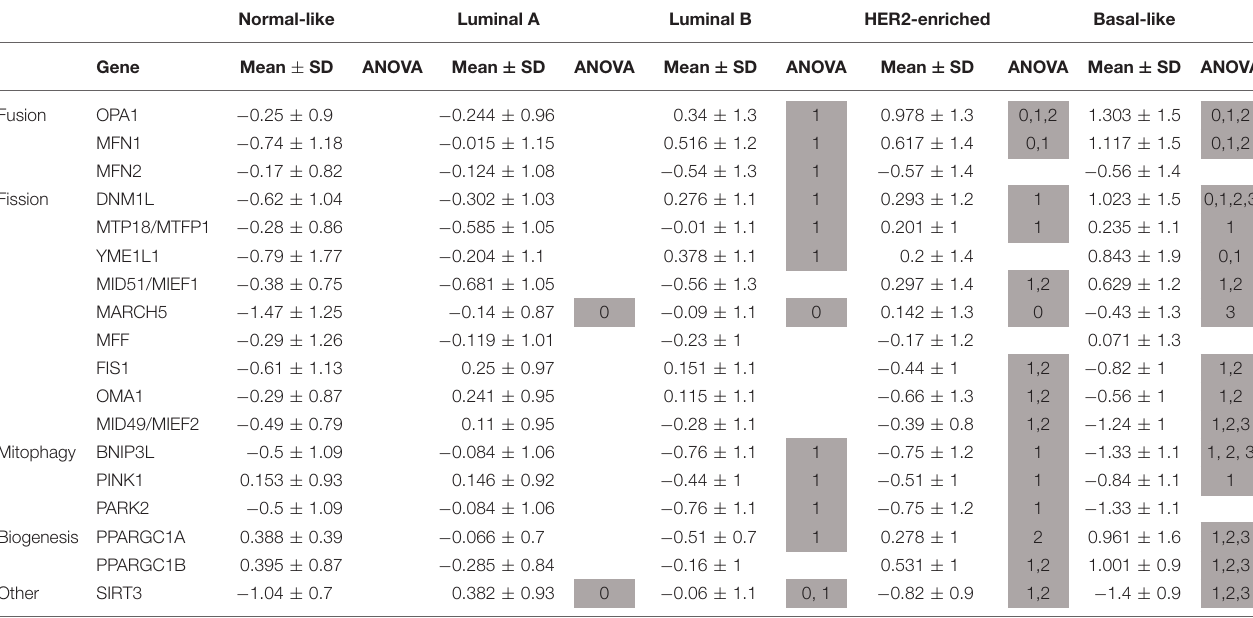
TABLE 1 | Breast cancer subtypes show differences in the expression level of mitochondria-related genes.